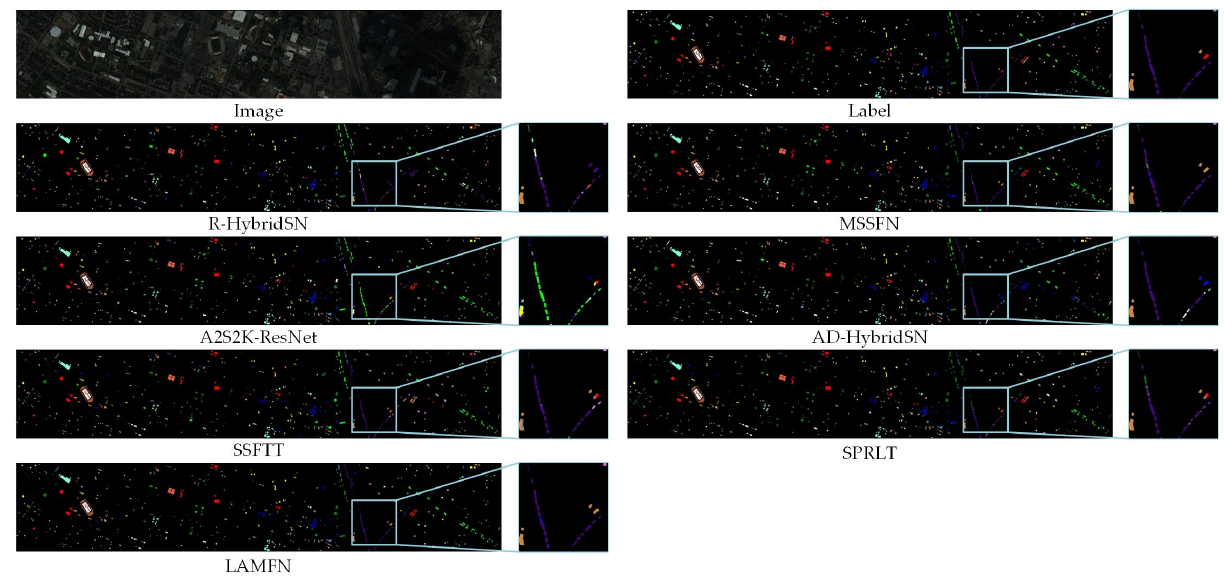
Figure 7. Classification maps of all models for HU dataset.